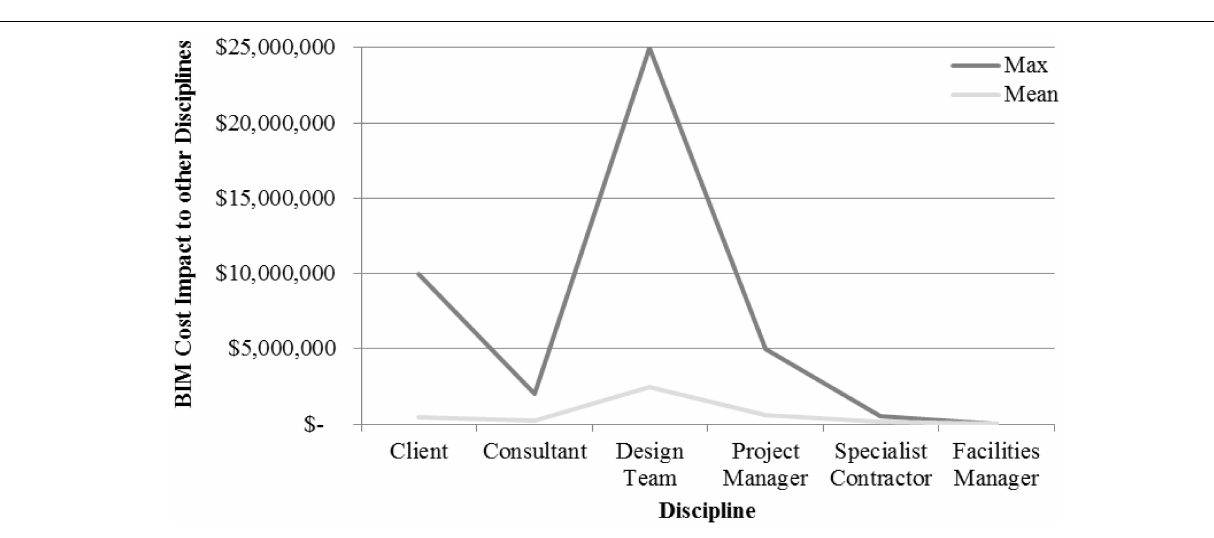
FIGURE 3 | Perceived total cost impact of BIM to other megaproject stakeholders (Day,